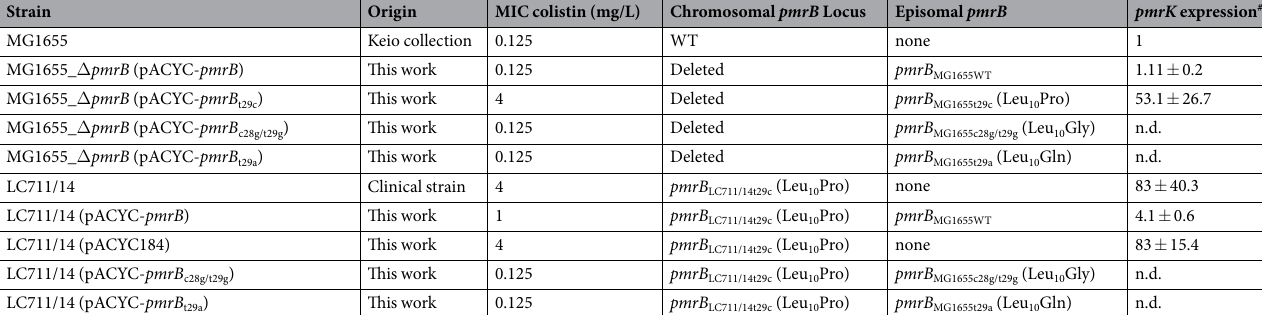
Table 1. Colistin MICs and expression levels of pmrK of different E. coli strains and transformants complemented with the pACYC- pmrB , pACYC- pmrB t29c , pACYC-pmrB c28g/t29g and pACYC- pmrB t29a plasmids. # The fold differences obtained were normalized against the MG1655 values. n.d. not